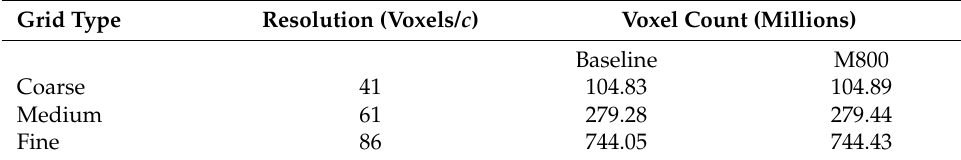
Table 3. Simulation domain specifications for grid convergence study